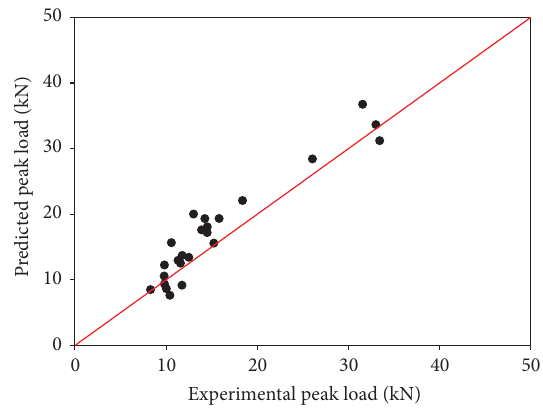
Figure4:Comparisonofpredictedandexperimentalultimateloads using Dai’s method. Average ratio of predicted to experimental ultimate load =